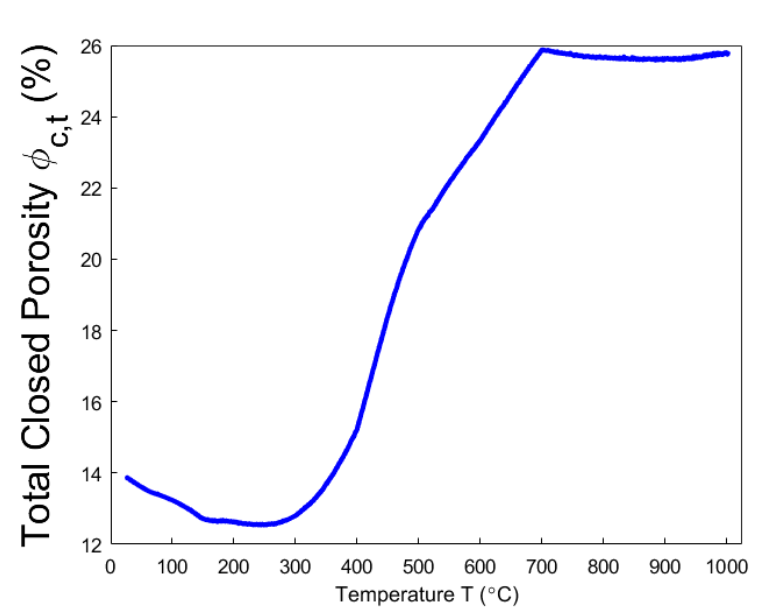
Figure 14. Total closed porosity.